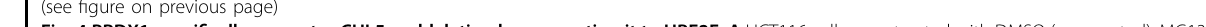
Fig. 4 PRDX1 speci fi cally promotes CUL5 neddylation by connecting it to UBE2F. A HCT116 cells were treated with DMSO (as a control), MG132 (10 μ M), or MLN4924 (1 μ M) for 10 h prior to co-IP and WB analyses. B In HCT116 cells, PRDX1 inhibition led to a decrease in CUL5 neddylation and an increase in NOXA expression, while the opposite phenomenon occurred in PRDX1-overexpressing SW480 cells. These effects of PRDX1 overexpression on CUL5 neddylation and NOXA ubiquitination in SW480 cells were abolished when the same two groups of cells were treated with MLN4924: SW480 cells transduced with pLenti plasmids were treated with 1 μ M MLN4924 and/or 10 μ M MG132 for 10 h before co-IP and WB analyses. C , D WB analysis of the changes in E1 activating enzymes (APPBP1-UBA3), E2 conjugating enzymes (UBE2F and UBC12) and CUL family proteins (CUL1-5). HCT116 ( C ) and DLD1 ( D ) cells were infected with lentivirus expressing the indicated shRNAs before being harvested for WB analysis. E PRDX1, UBE2F, and CUL5 bind to each other. HCT116 and DLD cell lysates were immunoprecipitated using an anti-PRDX1 or IgG control antibody and subsequently with Protein A + G Agarose prior to WB analysis to detect endogenous proteins as indicated. A 10% aliquot of each extract was used as input. F HCT116 cells were transfected with sh-PRDX1 before the lysates were immunoprecipitated using an anti-UBE2F or anti- CUL5 antibody and subsequently with Protein A + G Agarose prior to WB analysis to further determine the relationship of the three indicated